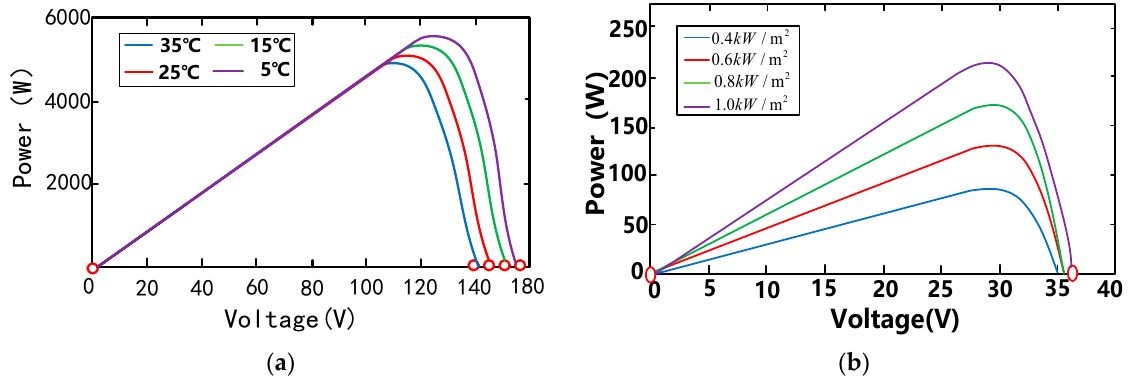
Figure 5. The power characteristics of PV modules under different ambient temperatures ( a ) and solar irradiance ( b ).